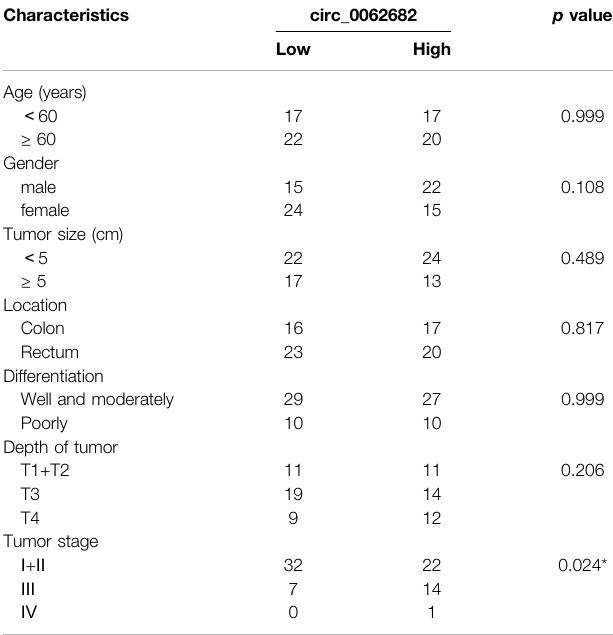
features in CRC. Characteristics circ_0062682 p